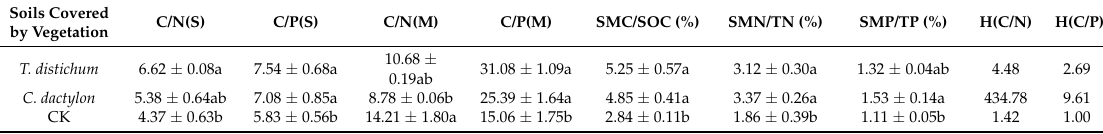
Table 3. The element ratio of soil and microbial C, N, P, and stoichiometric homeostasis. Soils Covered by